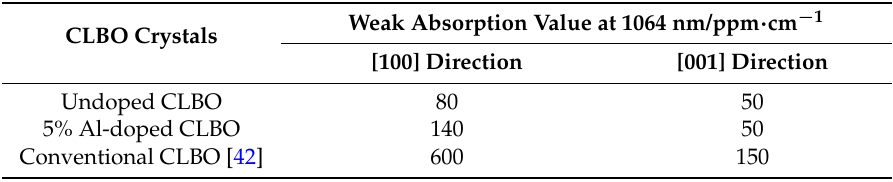
Table 2. Weak absorption values of CLBO crystals.